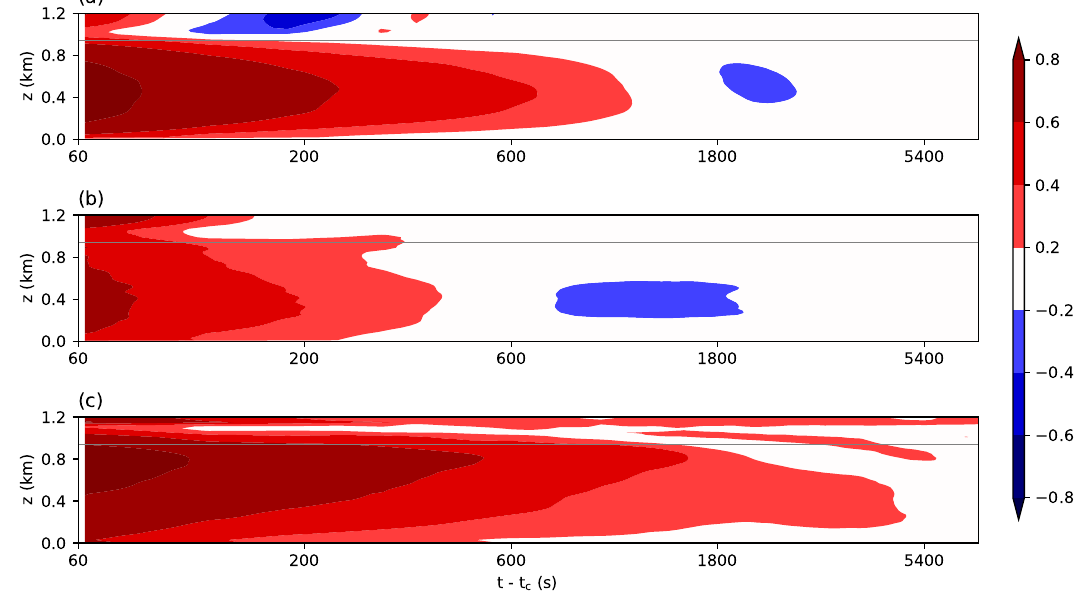
Figure 7. Time series of horizontal pattern correlations of ( a ) vertical velocity, ( b ) potential temperature, and ( c ) scalar concentration. Correlations between the values at t = t c and those at the corresponding moment at every horizontal plane are calculated. The gray lines indicate z i